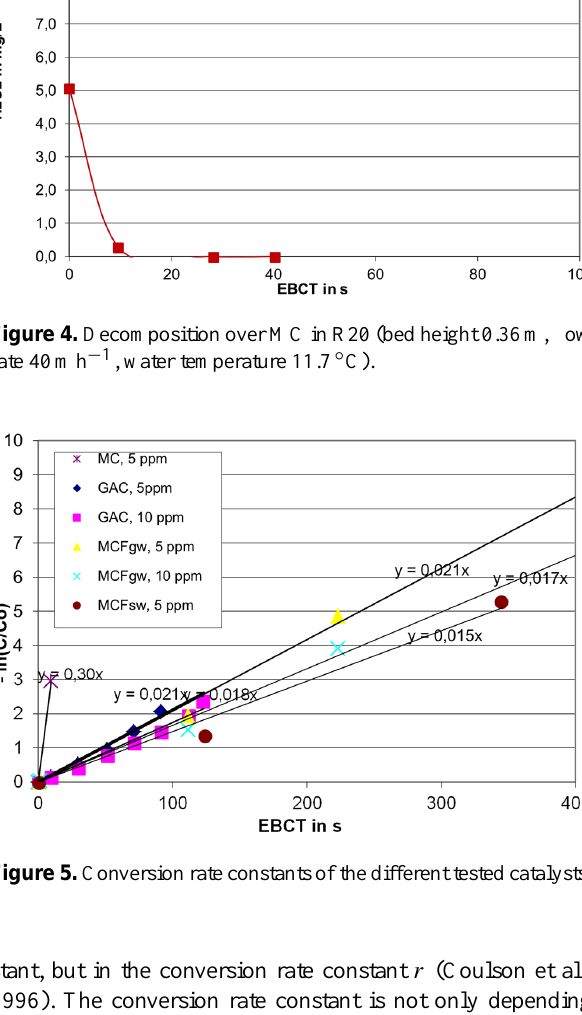
stant, but in the conversion rate constant r (Coulson et al., 1996). The conversion rate constant is not only depending of temperature and pressure (as in homogeneous milieu), but also on contact surface of the catalyst and hydraulic condi- tions in the reactor. In case of a first order reaction, a lin- ear relation exist between the negative natural logarithm of the quotient of the effluent hydrogen peroxide C and influent concentration C 0 and the reaction time ( − ln C / C 0 vs. t